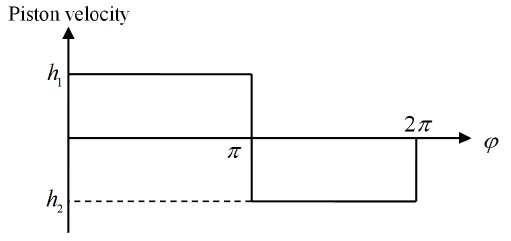
Figure 4. Imaginary piston velocity of the two-piston pump.